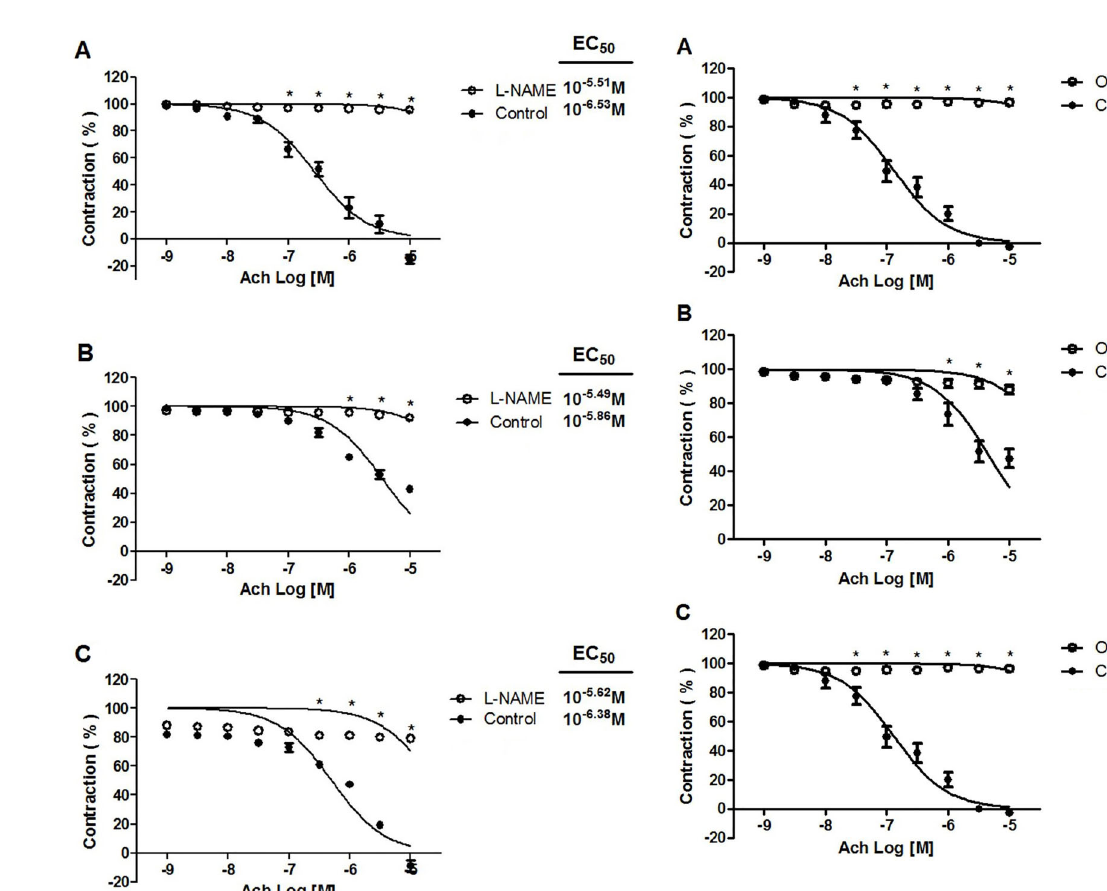
Figure 2. Effect of L-NAME (10 – 5 M) on acetylcholine (Ach) relaxation of endothelium-intact rat aortic rings precontracted with 10 – 6 M phenylephrine. The rings were extracted from rats fed: A ) the standard diet; B ) the cafeteria-style (CAF)-diet; and C ) the CAF-diet plus rosuvastatin (RSV) treatment. Data are reported as means ± SE of n=6 observations. *P o 0.001 vs control (two-way ANOVA).